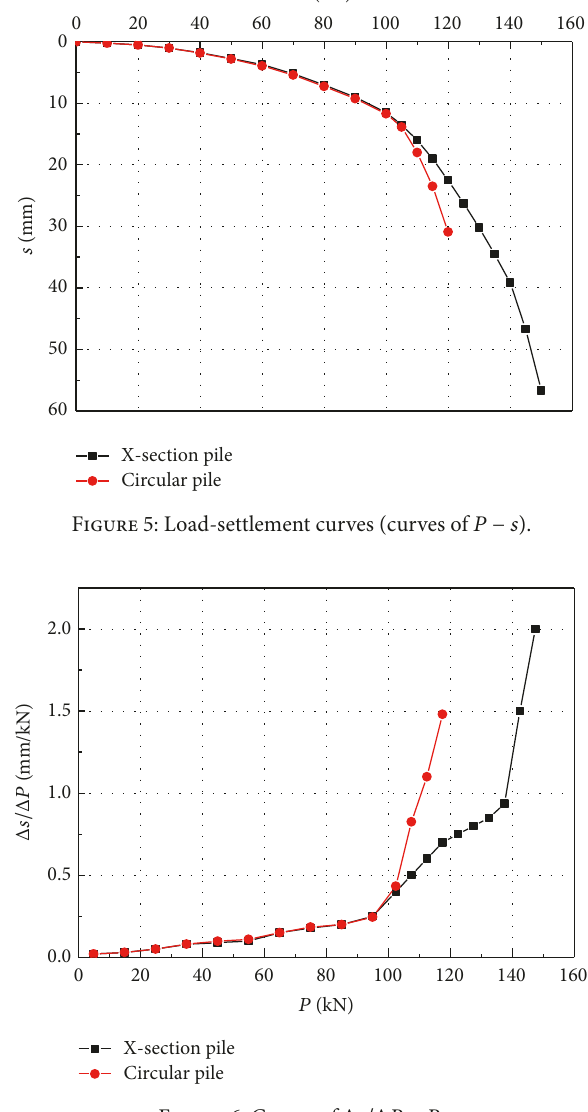
Figure 6: Curves of Δ𝑠/Δ𝑃 − 𝑃